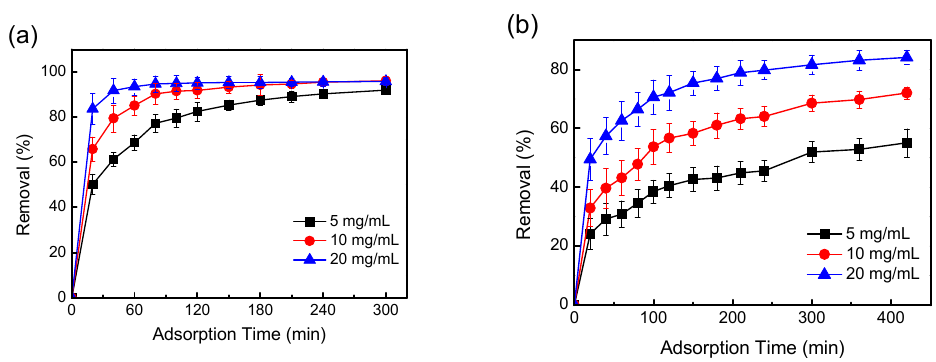
adsorption of SDBS observed was as 345 mg/g (for a 10 mg/mL initial SDBS concentration in SDBS/Cs